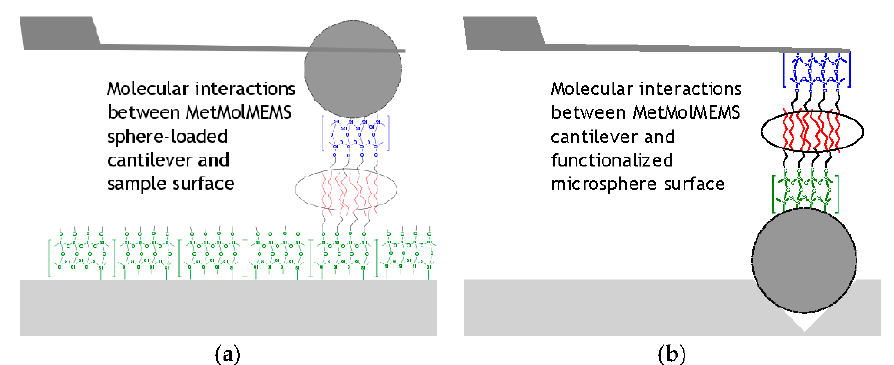
Figure 2. Schematic illustration of F-z spectroscopy investigation with SiO 2 or Au coated SiO 2 spheres; ( a ) This setup involves loading the cantilever with the sphere and investigating interactions between this functionalized sphere and flat surface; ( b ) setup, which involves sphere placed in with inverted pyramid arrays and investigating interactions between functionalized surfaces of sphere and flat gold layer on the cantilever.